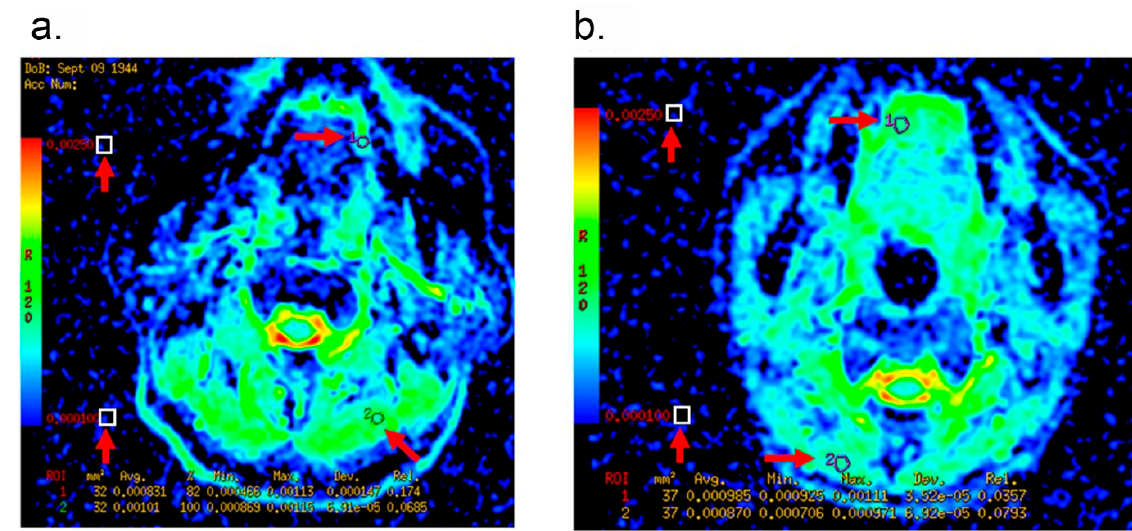
Figure 2. Representative MRI images of patients with cT1-2 OTSCC. Arrows indicate the region of interest (ROI) of the tumor and the non-tumor tissues for ADC measurements. ( a ): A 70-year-old male patient with Recurrence. The ADC value of tumor was measured as 0.831 × 10 − 3 mm 2 /s, and the ADC ratio was 0.822. ( b ): A 41-year-old female patient without Recurrence. The ADC value of tumor was measured as 0.985 × 10 − 3 mm 2 /s, and the ADC ratio was